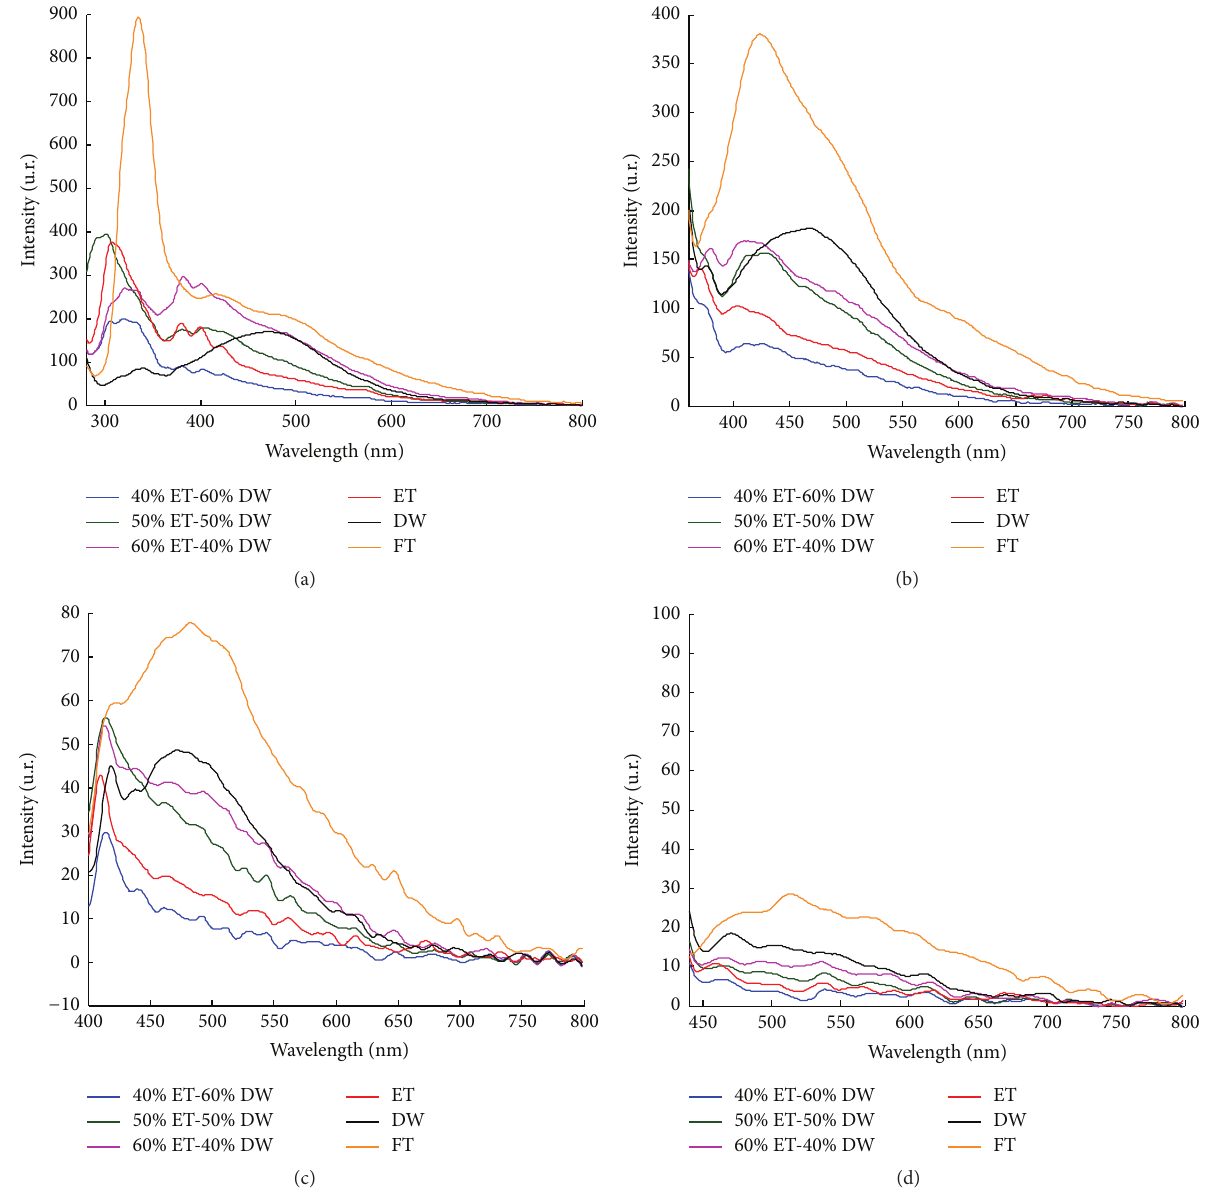
Figure 5: Fake tequila fluorescence (FT) compared to ethanol and distilled water mixtures fluorescence at different excitation wavelengths. (a) 255 nm, (b) 330 nm, (c) 365 nm, and (d) 405